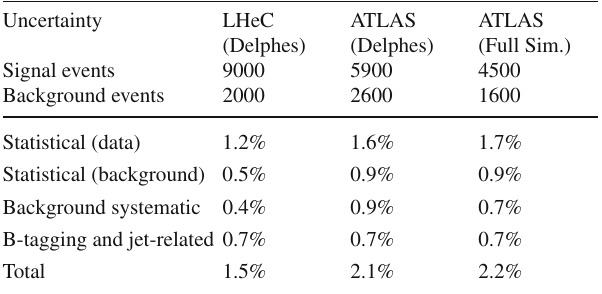
Table 6 Number of expected signal and background events using a BDT-based selection as well as the expected uncertainties on the cross section for different